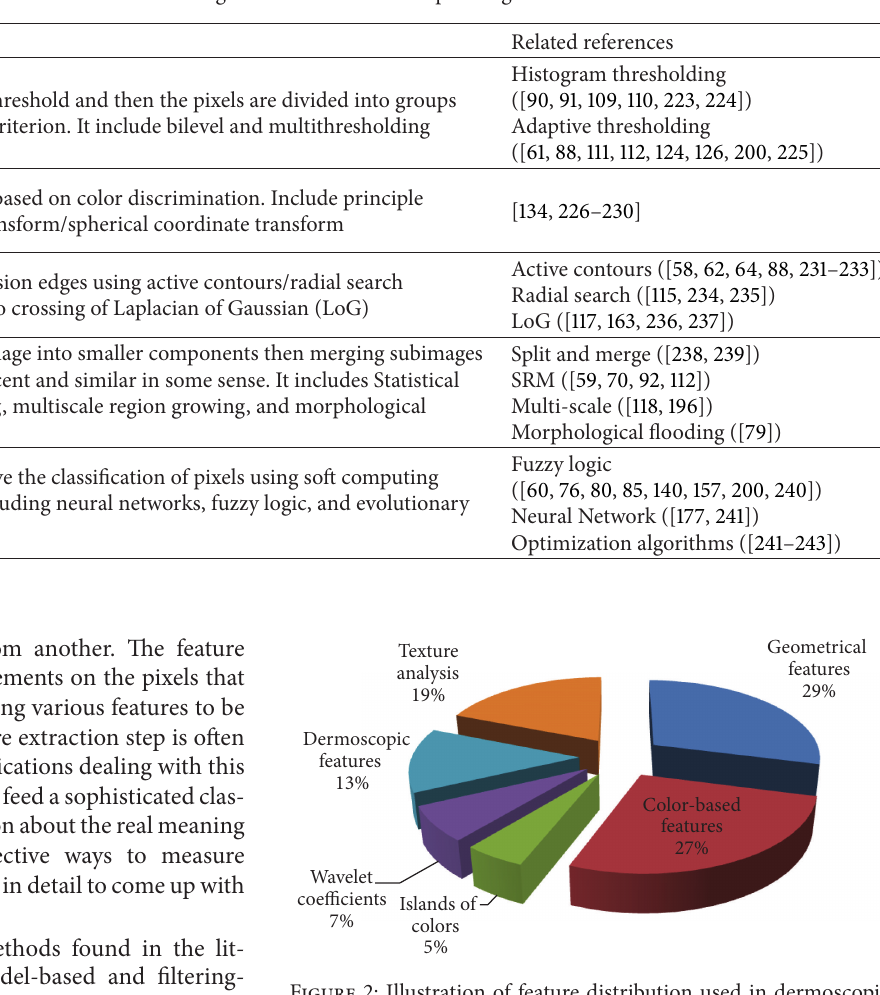
Table 2: Methods for segmentation of dermoscopic images.